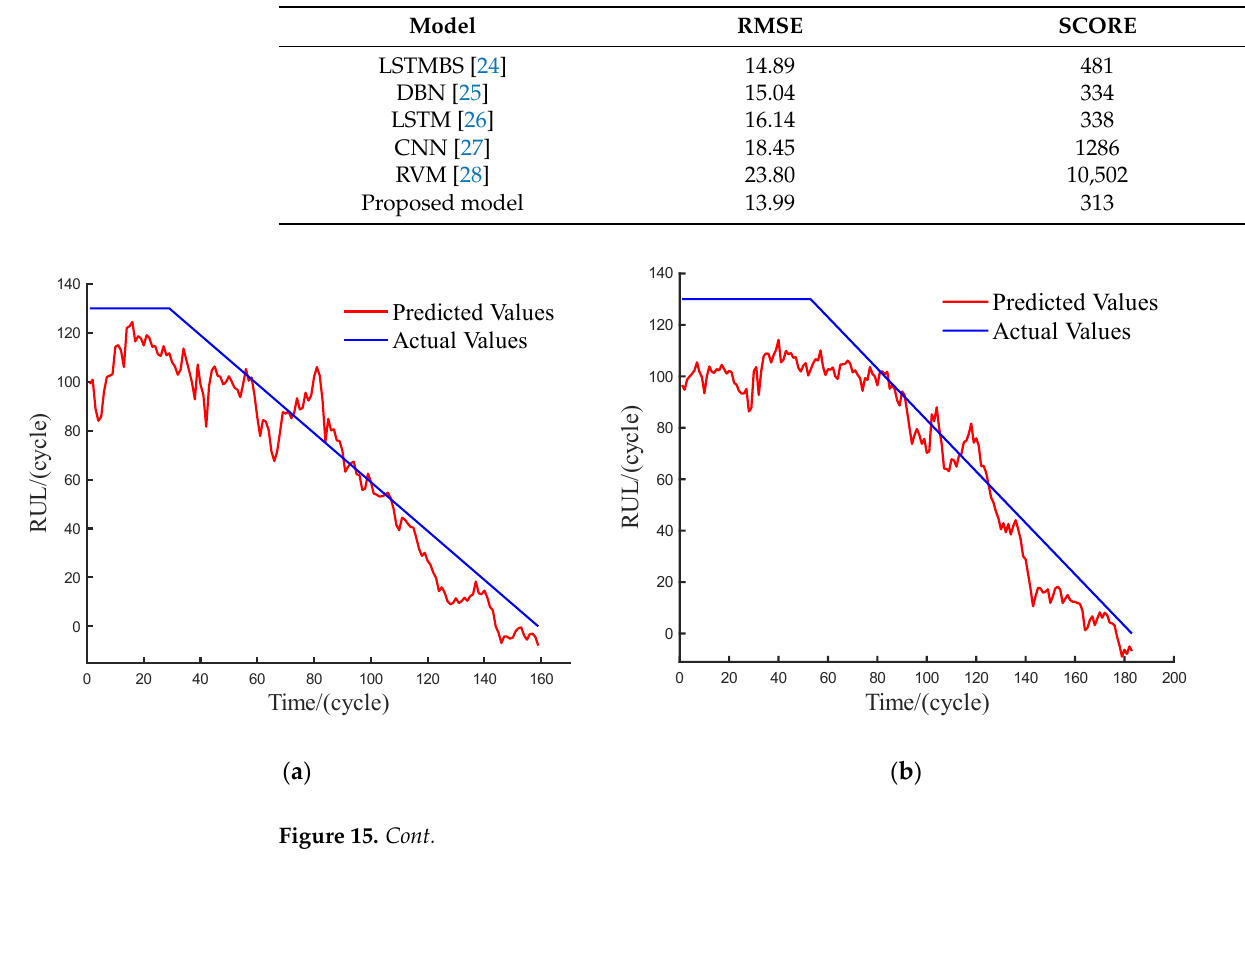
( c ) Figure 15. ( a ) RUL prediction results for engine units #52 of FD001; ( b ) RUL prediction results for engine units #81 of FD001; ( c ) RUL prediction results for engine units #100 of FD001. 4. Conclusions Based on the multi-head attention mechanism, a novel RUL prediction method for gradually degrading equipment was proposed, which uses discrete coefficients to con- struct evaluation indices for obtaining the optimal feature subset. This method effectively eliminates redundant features and improves the prediction accuracy of the model. The TCN-BILSTM network based on the multi-head attention mechanism was used to per- form individual feature mining to maximize information integrity and avoid information loss. In addition, the proposed method was verified using the IMS bearing dataset and the